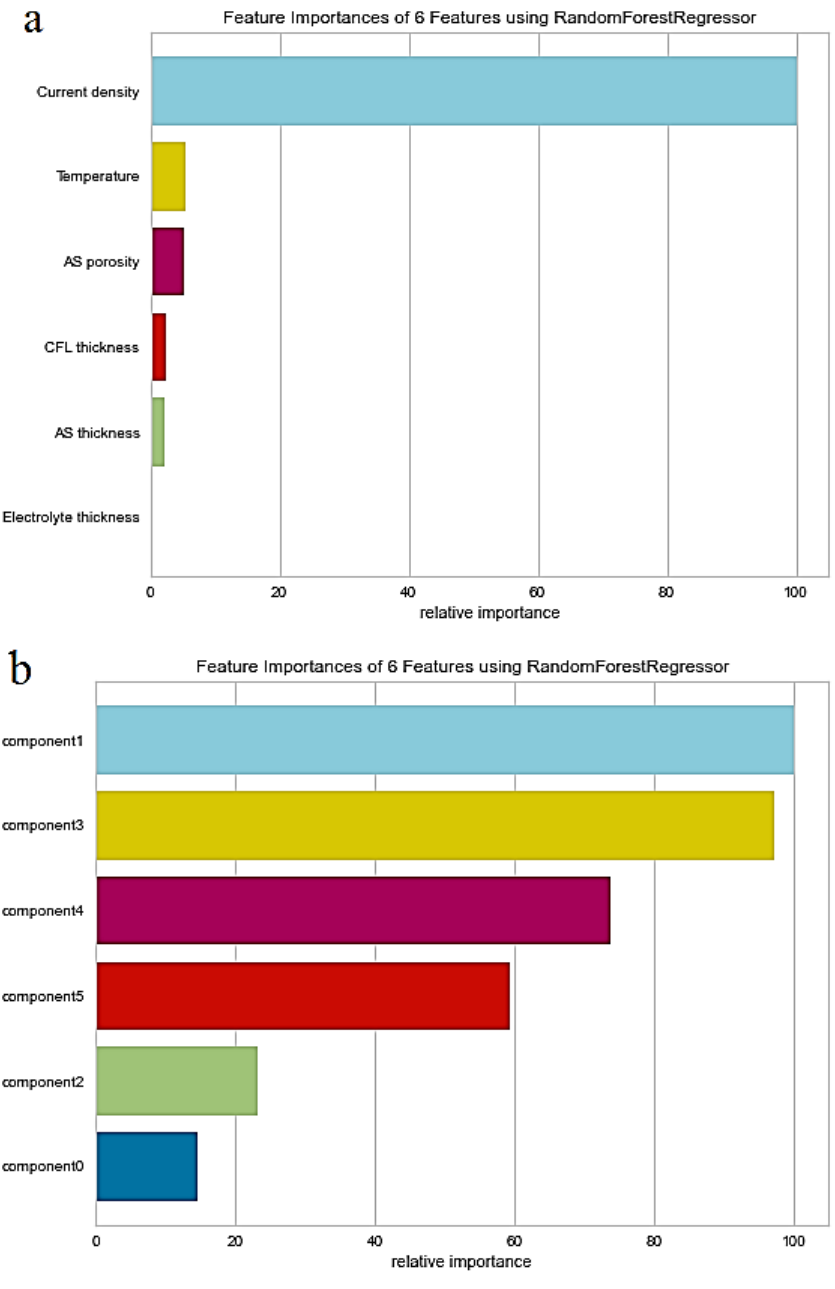
Figure 4. Random forest importance of ( a ) standard original features and ( b ) decomposed features using PCA.